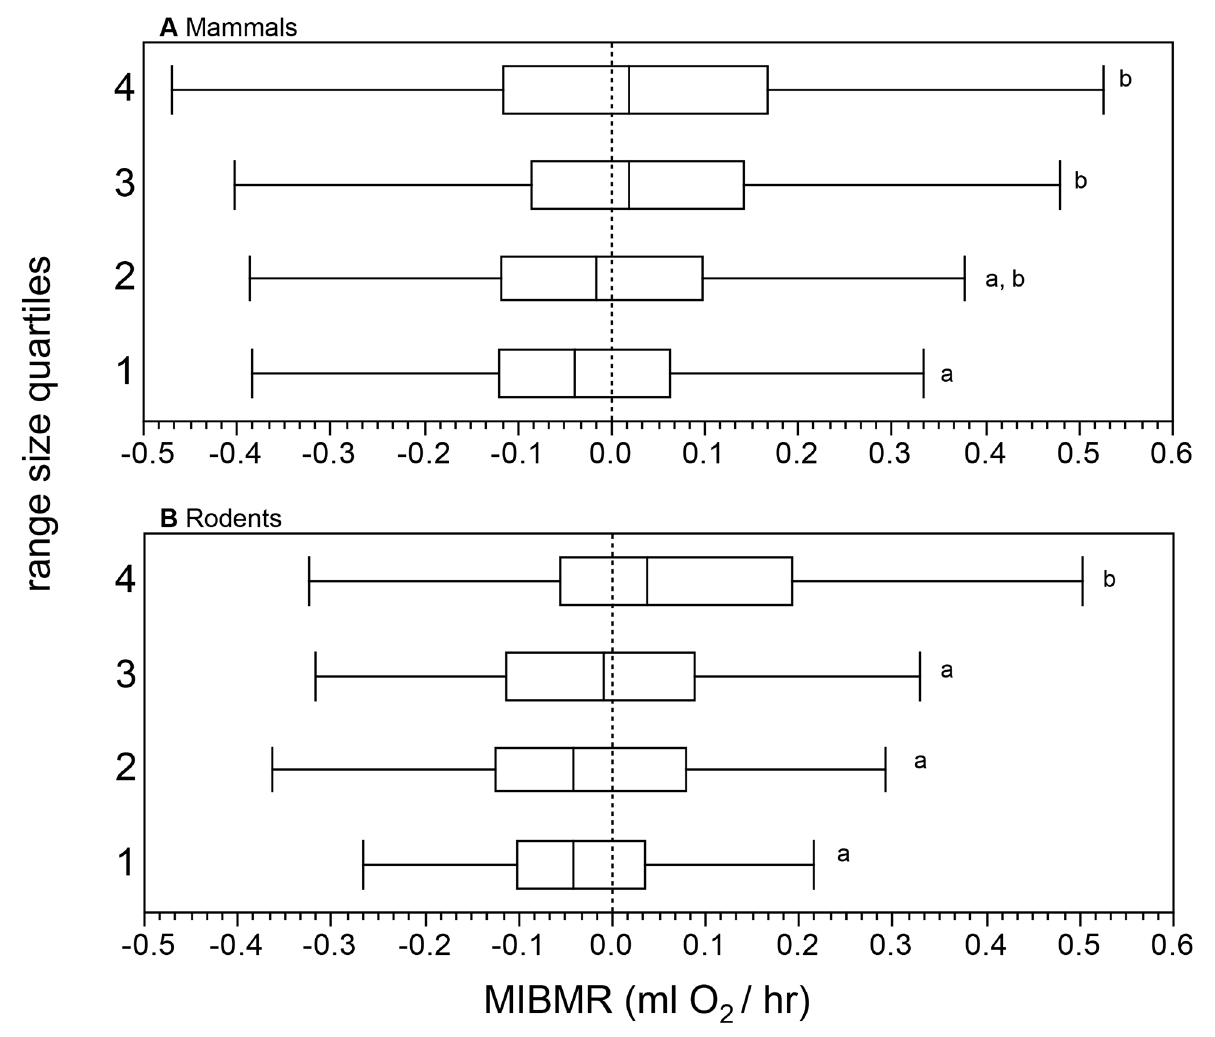
Figure 4. Box-plots of MIBMR among quartiles of geographic range size for (a) all mammals and (b) rodents. Different letters indicate significant differences among quartiles (ANOVA followed by Tukey-Kramer HSD